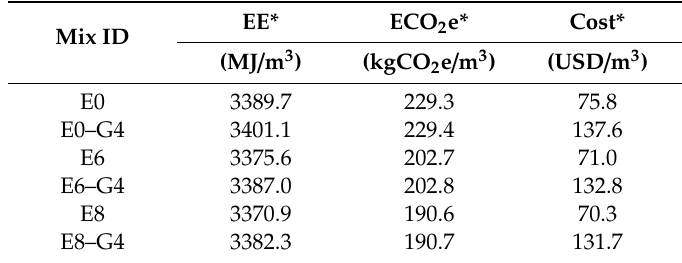
Table 8. Values of EE, ECO 2 e, and production cost calculated for the various samples. EE* ECO 2 Mix ID